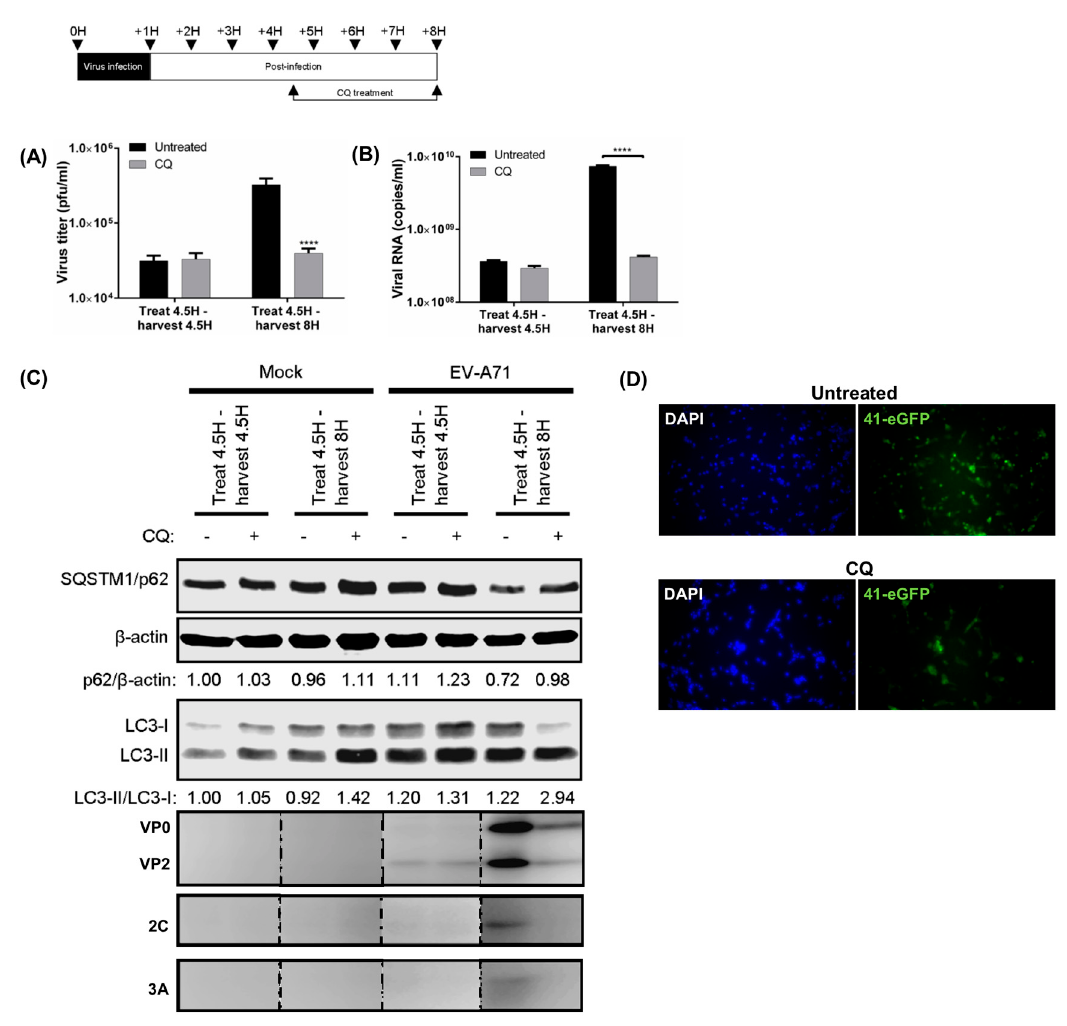
Figure 2. Inhibition of autolysosome formation inhibits virus RNA replication. RD cells were infected with EV-A71 (MOI = 10), and 50 µ M chloroquine (CQ) was added at 4.5 hpi; then, cellular lysates were immediately harvested or collected at 8 hpi for WB to determine ( A ) viral titres; ( B ) viral RNA copies; and ( C ) the SQSTM1/ β -actin, LC3-II/LC3-I ratios and viral proteins; ( D ) EV-A71 41-eGFP reporter (MOI = 10) was transfected and treated with 50 µ M CQ from one hpi to 8 hpi, and the eGFP signal was observed with fluorescence microscope. Error bars, means ± SD of 3 independent experiments. One-way ANOVA and Student’s t -test: * p < 0.05, ** p < 0.01, and **** p < 0.0001.